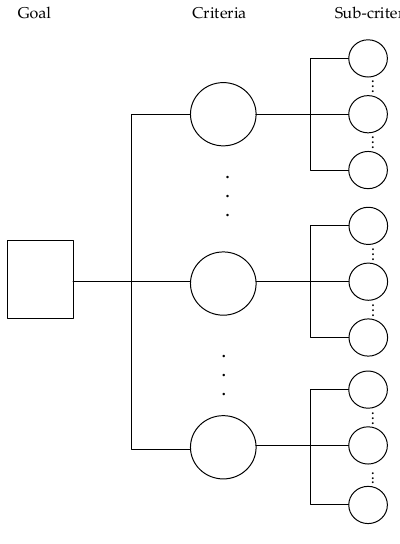
Figure 1. The hierarchical structure.